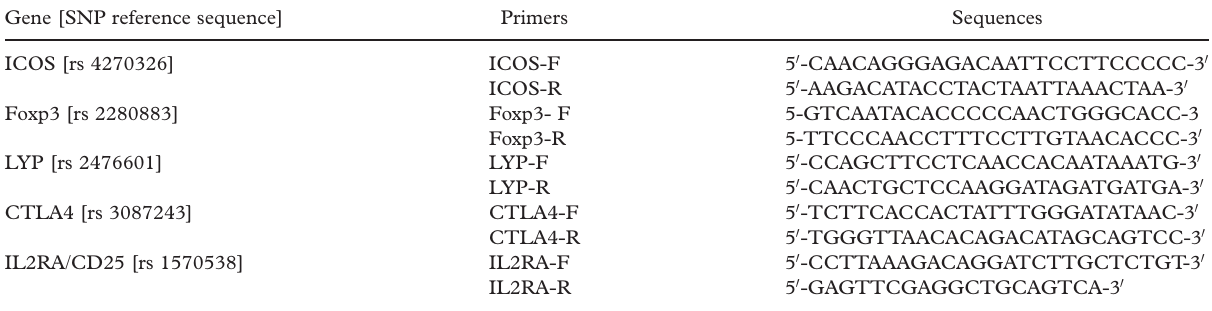
Table I. Primers used for SNP genotyping.